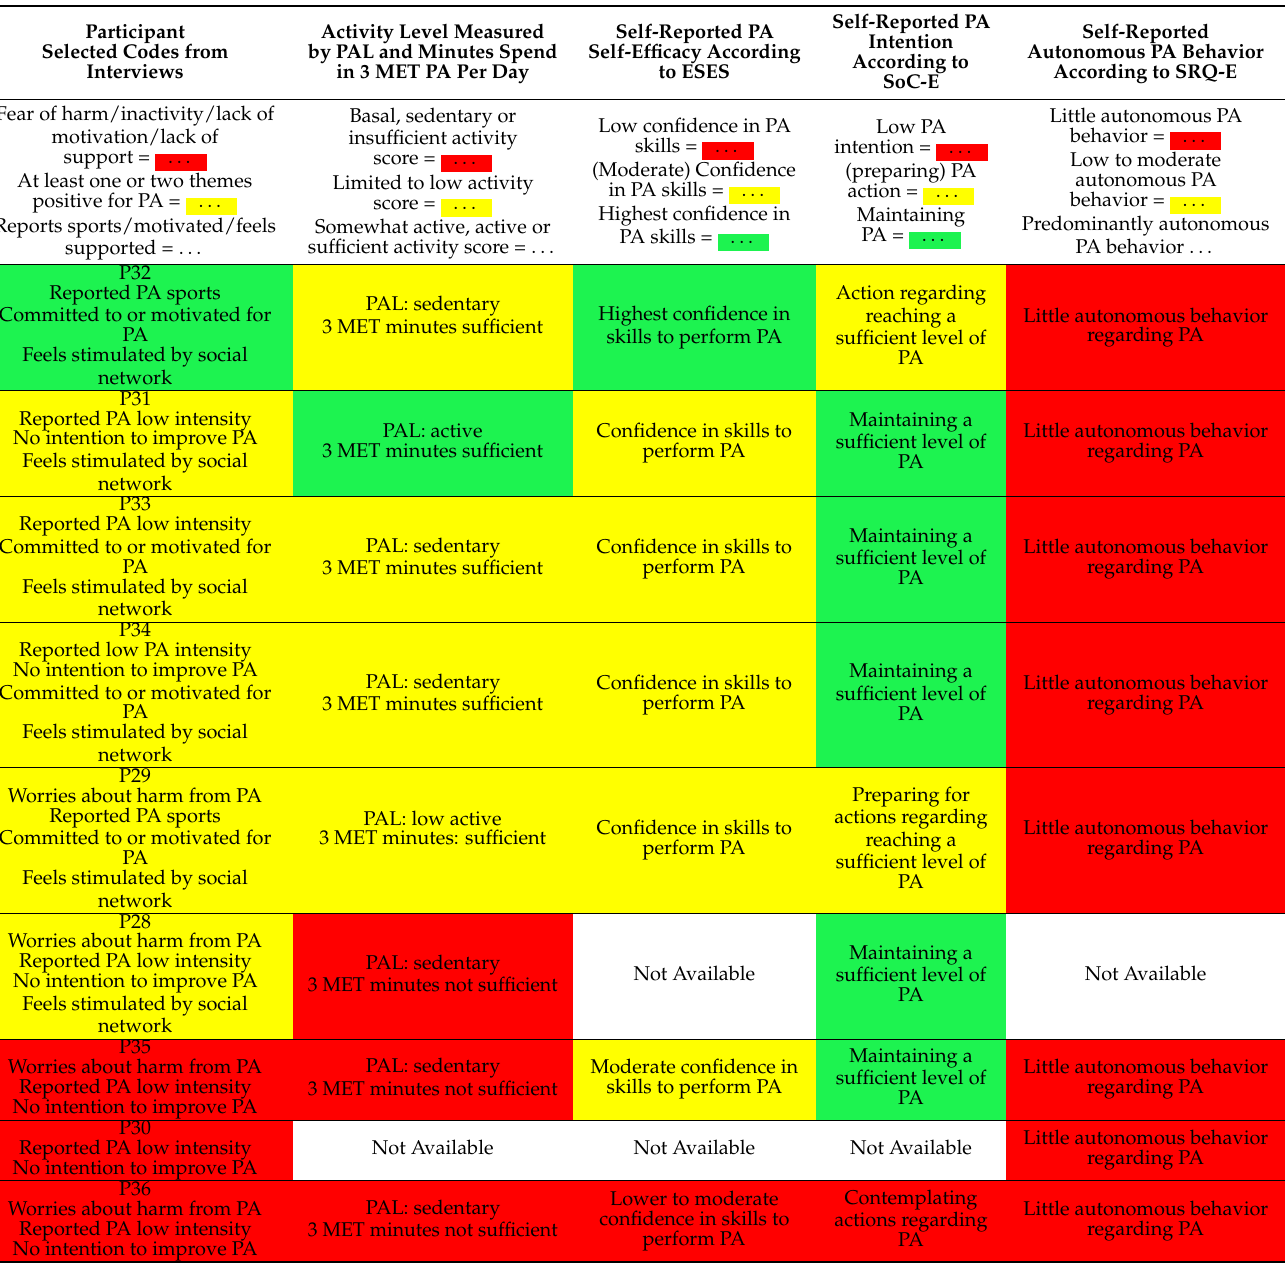
Table 2. Combined qualitative and quantitative results on participant